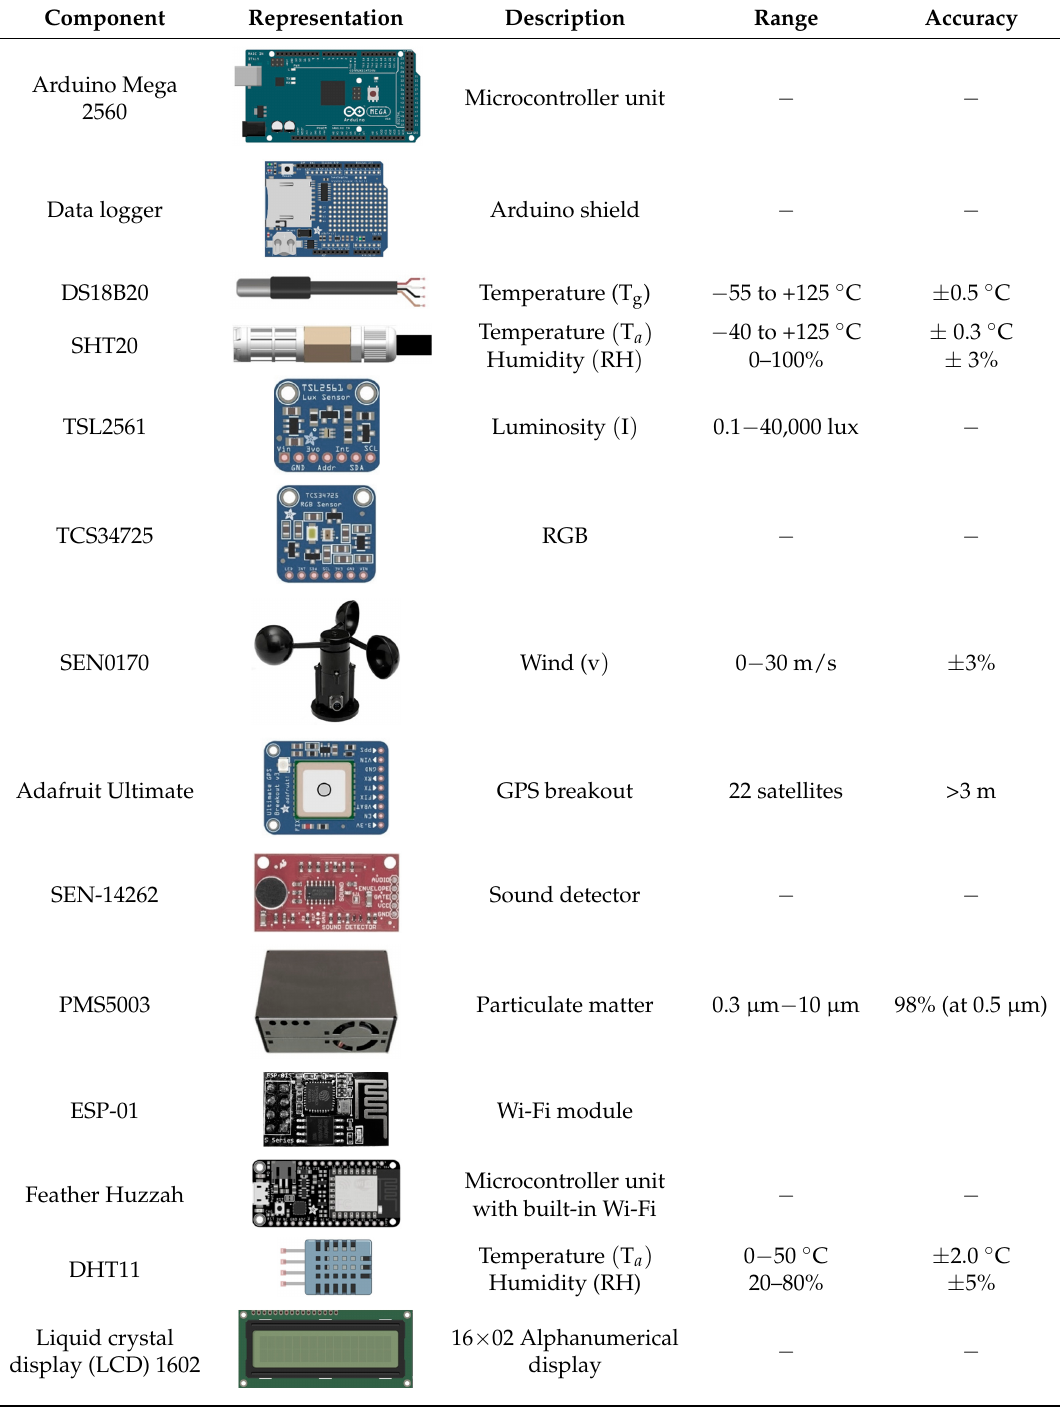
Table 1. List of components for the Weather-Gear